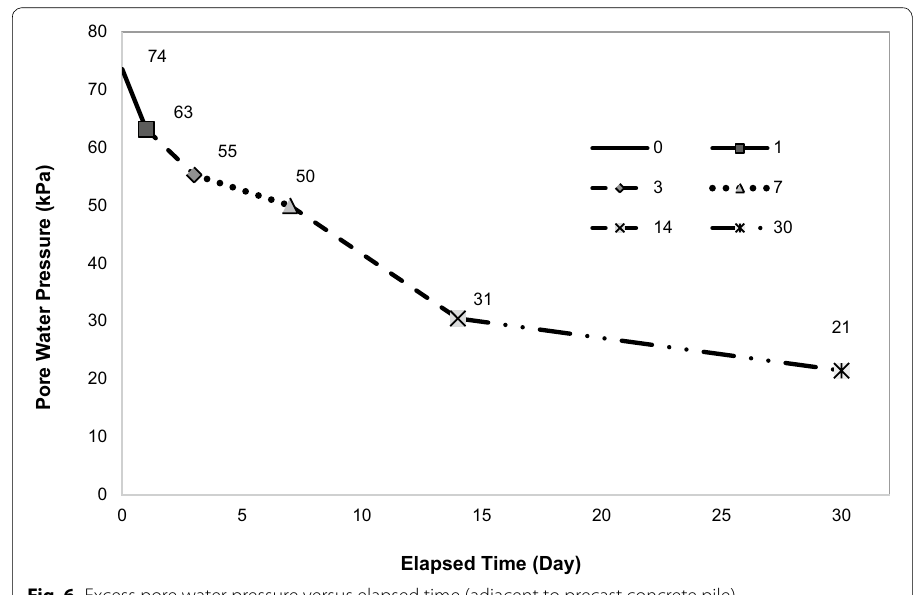
Fig. 6 Excess pore water pressure versus elapsed time (adjacent to precast concrete